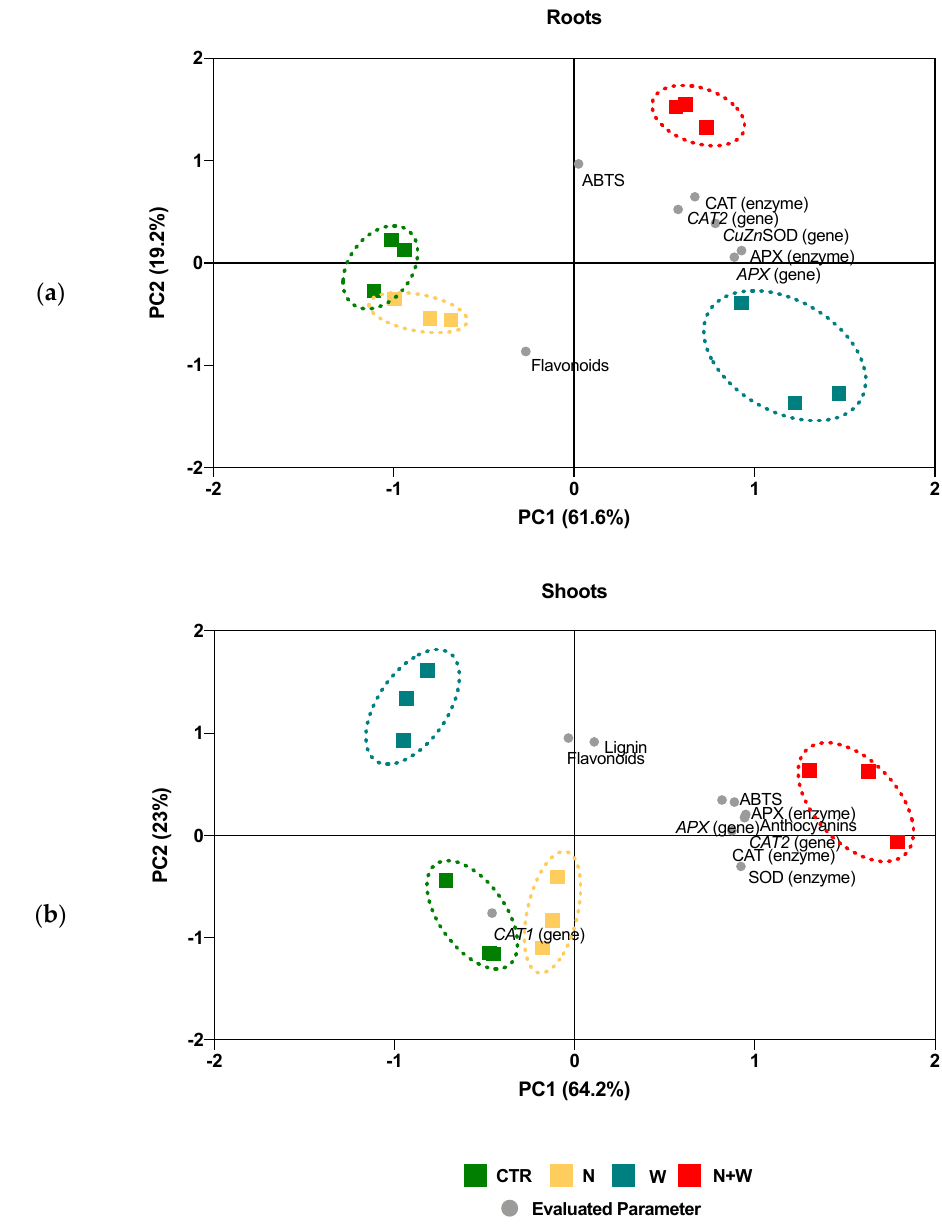
Figure 7. Principal component analysis (PCA) of the antioxidant system in roots ( a ) and shoots ( b ) evaluated in tomato plants cv. Micro-Tom grown for 16 days under control (CTR; 10.5 mM N + 100% W), nitrogen deficit (N; 5.3 mM N + 100% W), water deficit (W; 10.5 mM N + 50% W) or combined nitrogen and water deficit (N + W; 5.3 mM N + 50% FC). The two principal components together (PC1, PC2) explained 81%, in roots, and 87%, in shoots, of the total variance found among treatments. Details on the abbreviations are given in Materials and Methods.